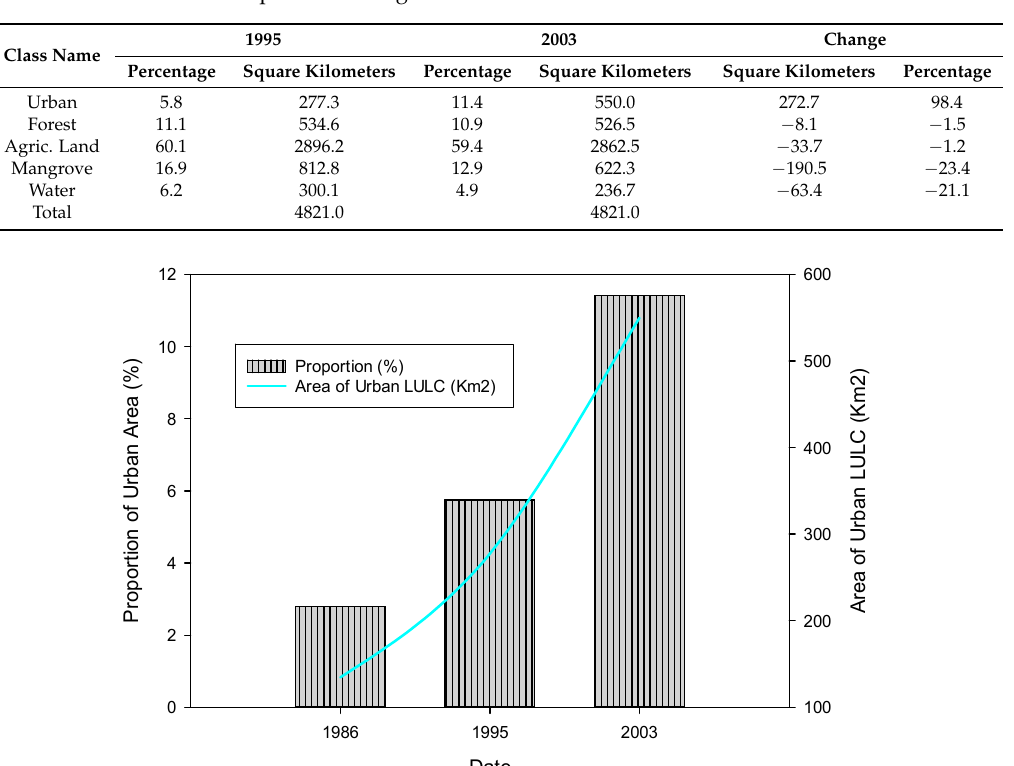
Figure 6. Proportion and trend of changes in urban area between 1986–2003. The bar chart presents the proportion of urban area for the respective dates, while the line graph shows the trend and change in urban land-use